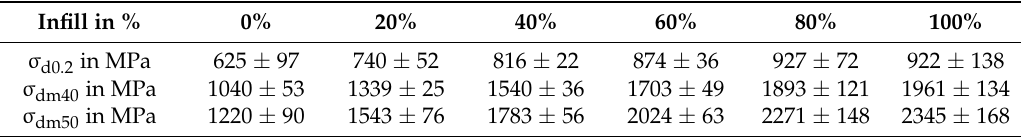
Figure 4. Compressive strength σ d0.2 , σ dm40 and σ dm50 in relation to infill. Table 6. Compressive strength in relation to infill percentage ( n = 6).